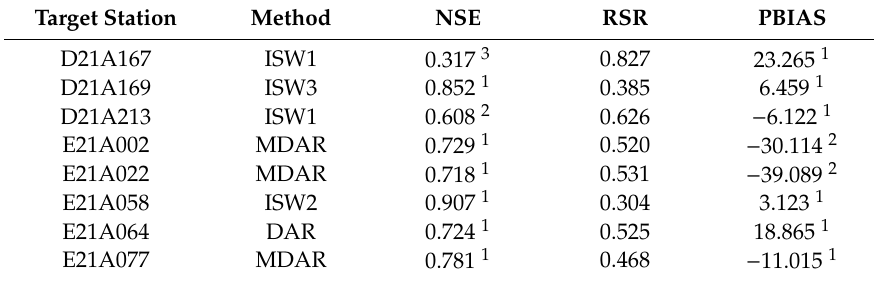
Table 9. Performance evaluation of the best statistical method without the moving average (MA) for each target station in the Middle Euphrates Basin.